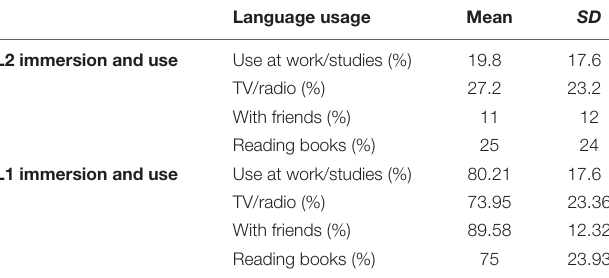
TABLE 2 | L1 and L2 immersion and usage of participants ( n =